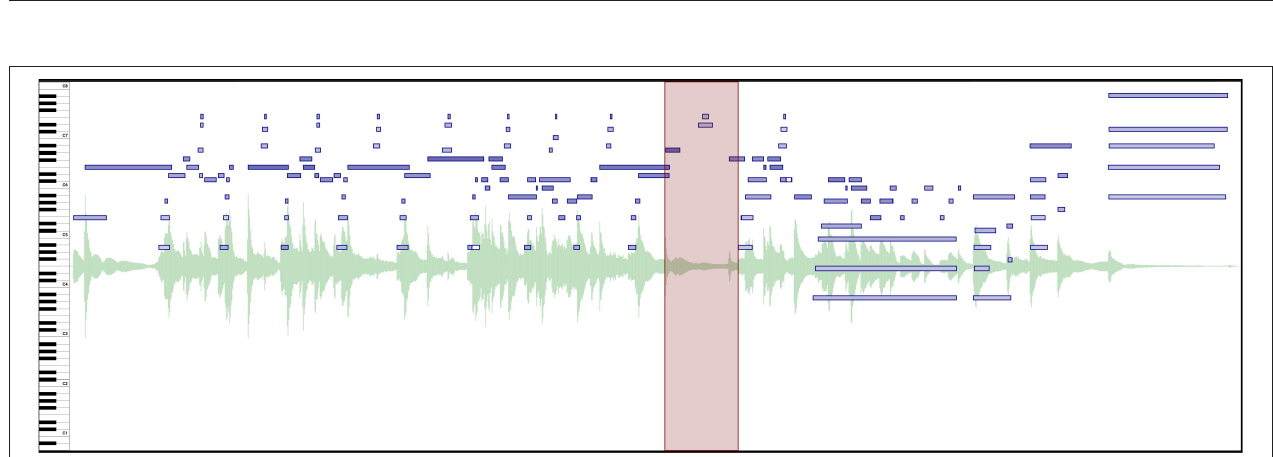
FIGURE 8 | Melodic salience highlighted in note groups (light red rectangles) as the notes of the main motive are made more present by the performer on an excerpt of Chopin’s Ballade No. 2 in F major. See Supplementary Video 6 in the Supplementary Materials to hear the music presented in this Figure.